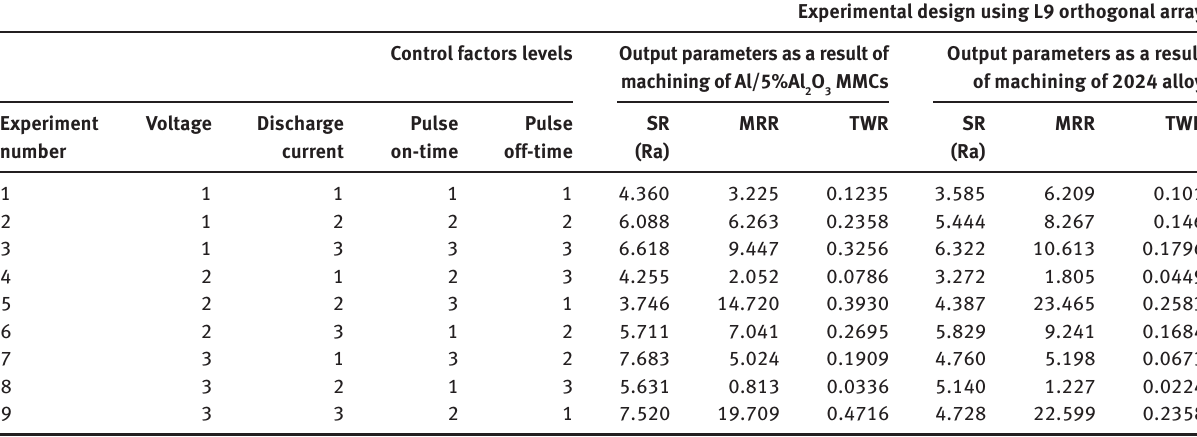
Table 5: Experimental design and results for MRR, SR, and TWR on two different materials